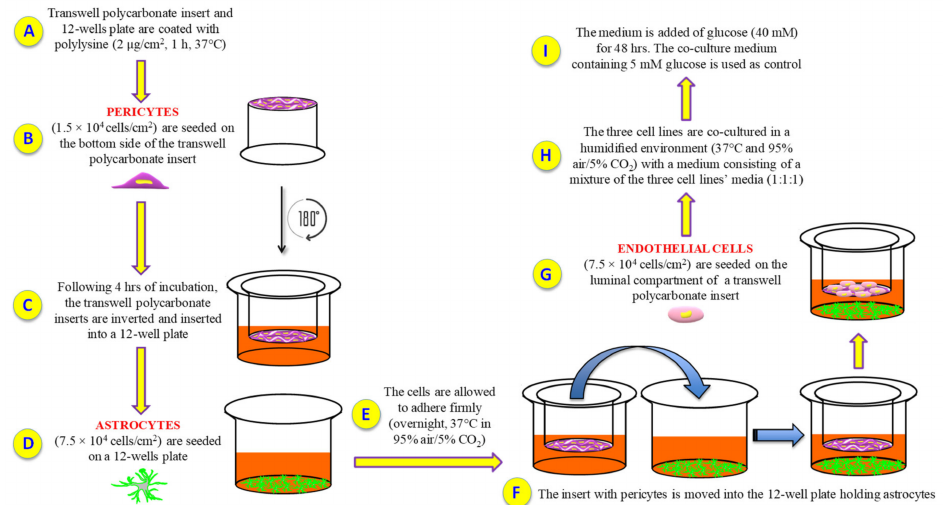
Figure 7. Experimental procedure followed to set up the in vitro BRB model. ( A ) Polylysine (PLL) coating; ( B ) human retinal pericytes are seeded on the bottom side of the insert; ( C ) insert is rotated of 180 ◦ and inserted into a 12-well plate containing pericytes medium; ( D ) human retinal astrocytes are seeded on a 12-well plate containing astrocytes medium; ( E ) cell incubation and adhesion; ( F ) the insert with pericytes is moved into the 12-well plate holding astrocytes; ( G ) human retinal endothelial cells are seeded on the top side of the insert; ( H ) cells are grown with a medium consisting of a mixture of the three cell lines’ media (1:1:1); ( I ) glucose was added in order to obtain high glucose